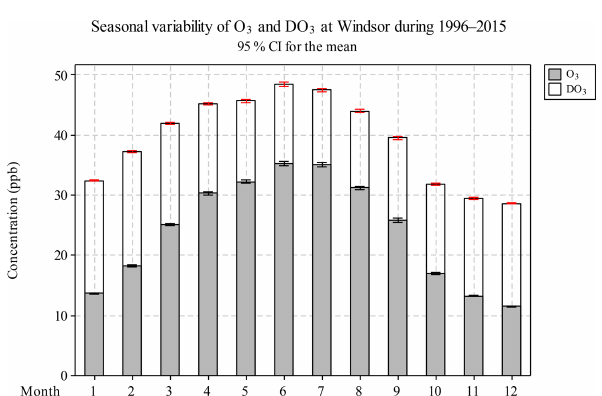
Figure 3. Monthly mean O 3 and DO 3 concentrations during 1996– 2015 in